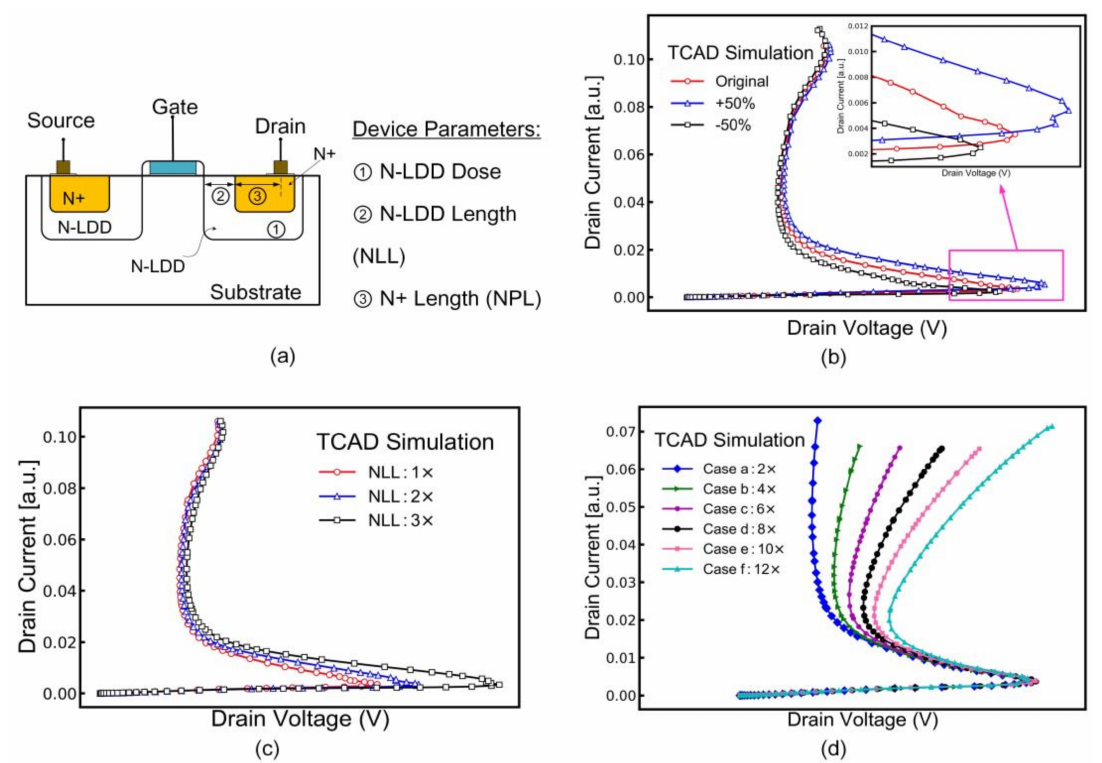
Figure 10. ( a ) Crosssection of LDD NMOS depicting various device parameters. IV curves of NMOS with varied ( b ) N − LLD dose, ( c ) NLL size, and ( d ) NPL size obtained using TCAD